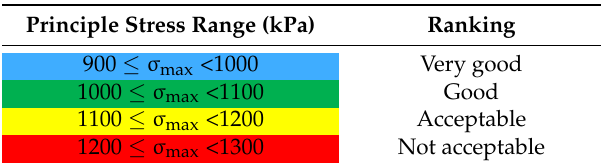
Table 9. Maximum principle stress ( σ max ) classification.